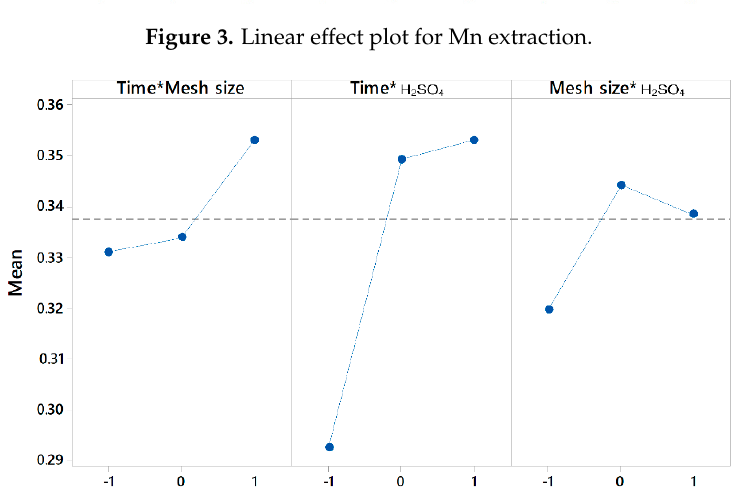
Figure 4. Interaction effect plot for Mn extraction.